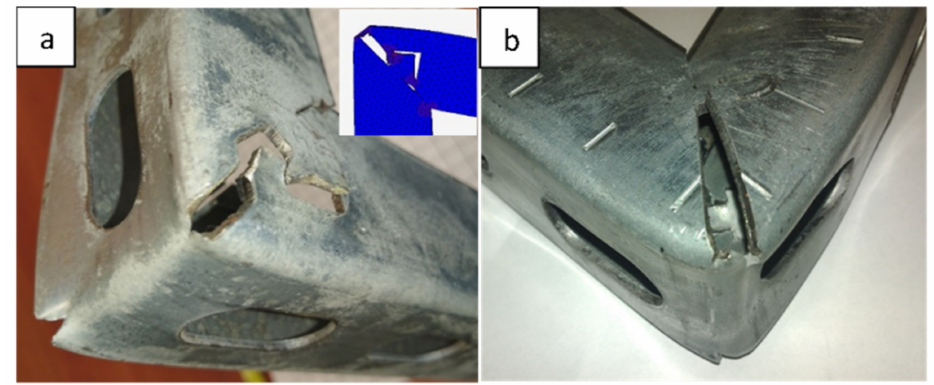
Figure 18. Consoles after testing—no catastrophic destruction regardless of the shape of a lock; ( a )—triangular lock with shelf; ( b )—semicircular lock without a